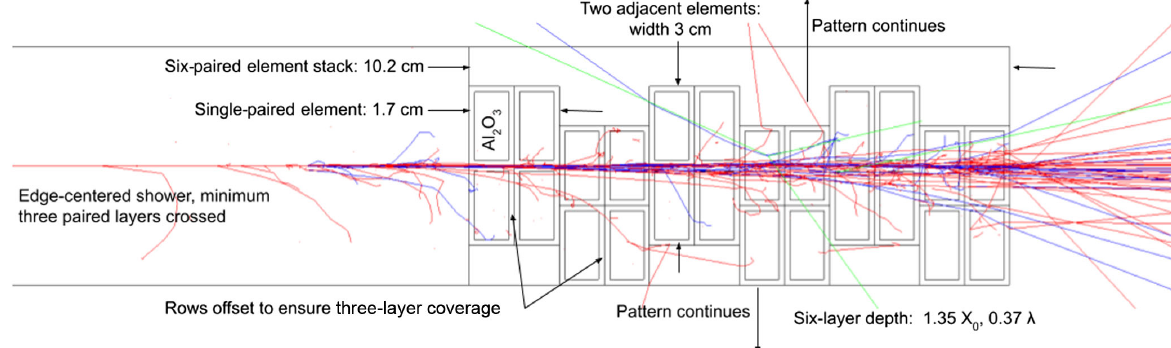
FIG. 20. A six-layer point design timing-plane detector using the methods we have described